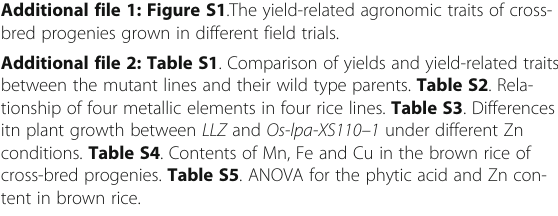
Additional file 1: Figure S1 .The yield-related agronomic traits of cross- bred progenies grown in different field trials. Additional file 2: Table S1 . Comparison of yields and yield-related traits between the mutant lines and their wild type parents. Table S2 . Rela- tionship of four metallic elements in four rice lines. Table S3 . Differences itn plant growth between LLZ and Os-lpa-XS110 – 1 under different Zn conditions. Table S4 . Contents of Mn, Fe and Cu in the brown rice of cross-bred progenies. Table S5 . ANOVA for the phytic acid and Zn con- tent in brown rice.